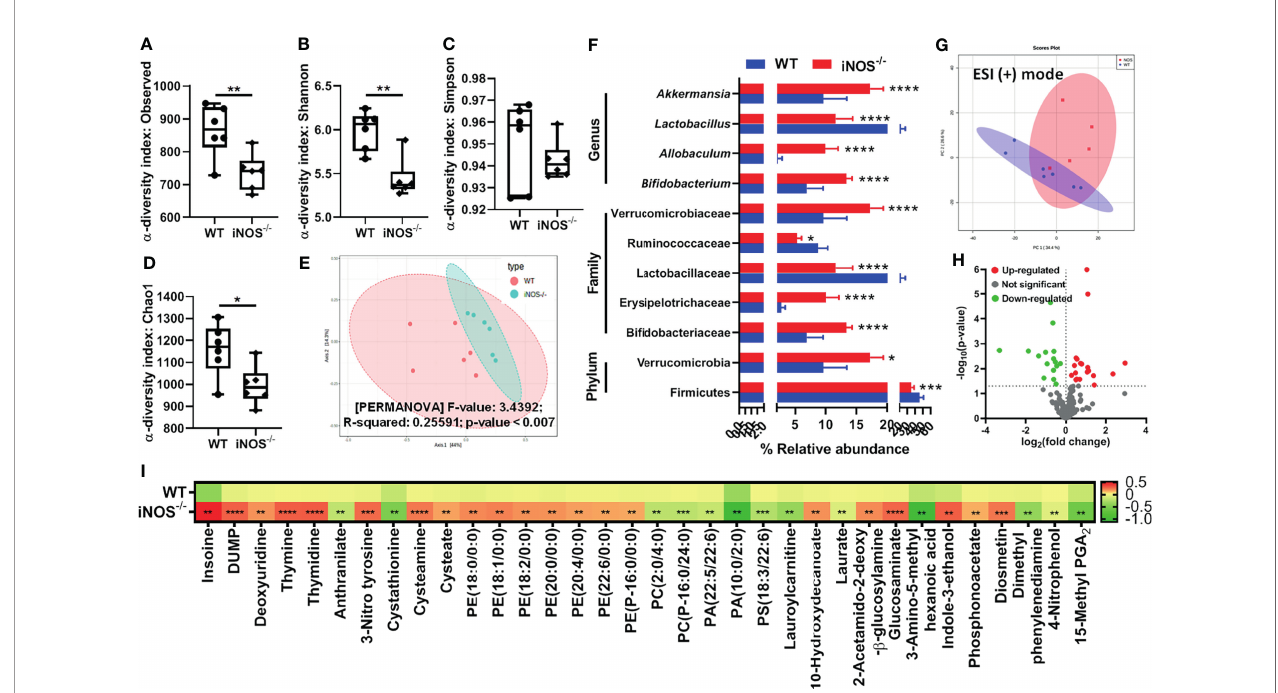
FIGURE 1 | Insulin-resistant iNOS − / − mice display atypical gut microbiota with gram-positive bacteria dominance and altered serum metabolome. Gut microbiota analysis in wild-type (WT) and insulin-resistant iNOS − / − mice. a -Diversity indices in stool samples: (A) observed, (B) Shannon, (C) Simpson, and (D) Chao1. (E) b - Diversity analysis via principal coordinate analysis (PCA) plot based on Bray – Curtis distance. Each dot represents an animal, projected onto the fi rst (horizontal axis) and second (vertical axis) variables. (F) Differentially abundant microbiota at the phylum, family, and genus levels. Serum metabolomic analysis in chow-fed WT and iNOS − / − mice in ESI (+) mode. (G) PCA score plot and (H) volcano plot of differential metabolites ( p < 0.05) between WT and iNOS − / − mice. Red in the volcano plot indicates signi fi cantly upregulated metabolites, green indicates the downregulated metabolites, and gray shows no signi fi cant difference. (I) Heatmap of differential metabolites found by metabolomics analysis in chow-fed WT and iNOS − / − mice. Data are represented as mean ± SEM ( n ≥ 6). * p < 0.05, ** p < 0.01, *** p < 0.001, **** p < 0.0001 vs. WT. See also Figure S1